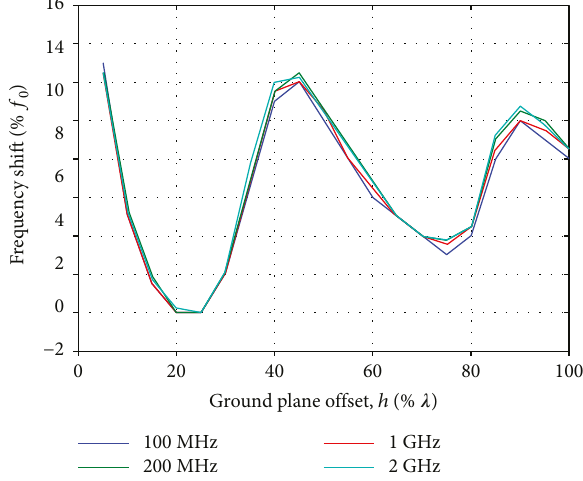
Figure 15: Frequency shift versus ground plane o ff set, h , in % λ